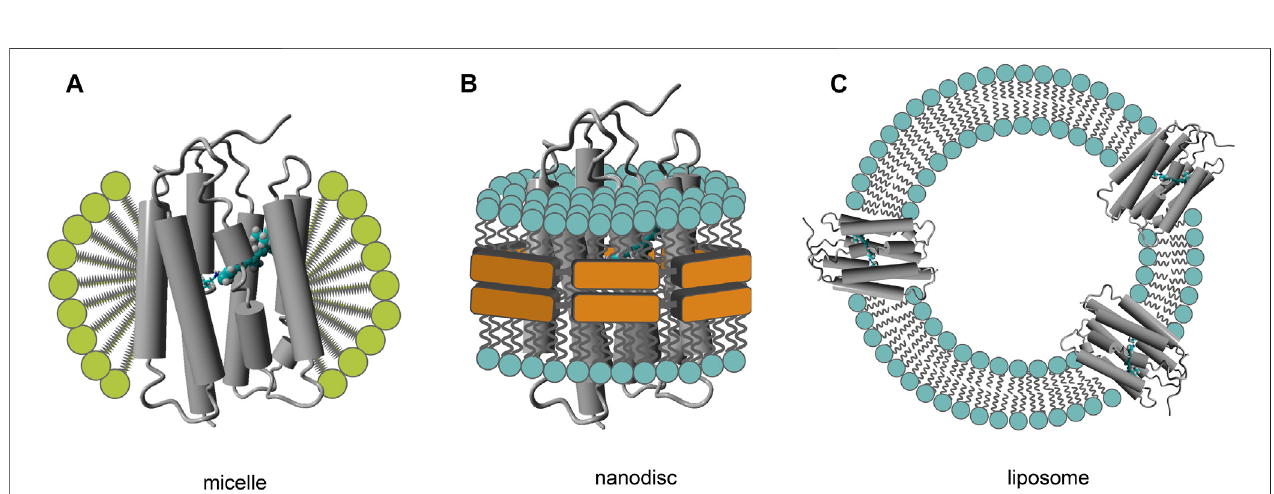
FIGURE 4 | Membrane mimics for puri fi ed membrane proteins. Schematics of the micellar (A) , nanodisc (B) and vesicular ( C ; proteoliposome) organization are displayed. Note that the relative dimensions are not to scale: diameters vary from 10 – 50 nm for the micelles and nanodiscs, and from 100 nm up to 10 µm for the liposomes.Severalamphipaticcomponents functioning asbilayer-stabilizing agents inthenanodiscs havebeen generated (MSPderivativesfrom lipoproteins, synthetic amphipols and SMAs, respectively), and are still under further development. Puri fi cation of the protein in a detergent environment generates the classical